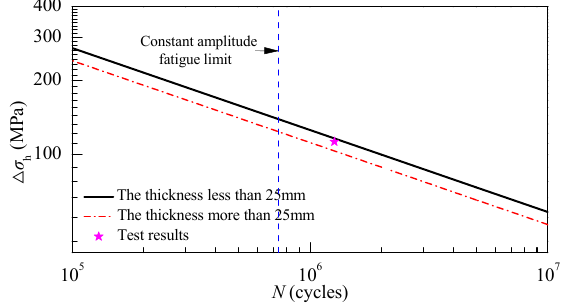
Figure 17. Fatigue design S - N curve.